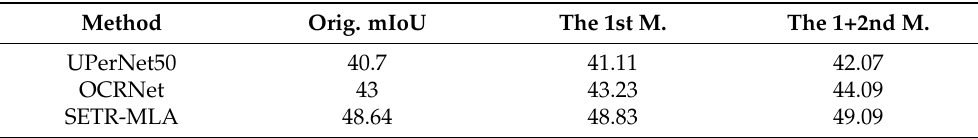
Table 3. Experimental results on the ADE20K dataset.